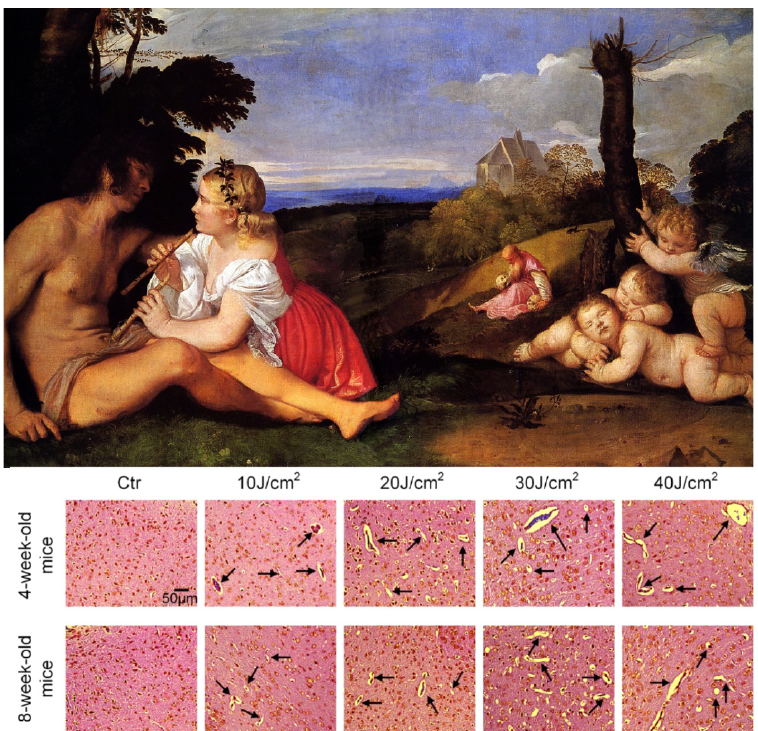
Fig. 4. The illustration of age di®erences in PDT-induced opening of the BBB. Histological analysis clearly demonstrates that PDT-induced opening of the BBB is accompanied by brain edema in laser °uence depended manner that is more pronounced in juvenile mice compared with adult mice. Ctr – the control group, no solute leakage; laser (10 – 20 – 30 – 40 J/cm 2 Þ causes the perivascular edema (black arrows), which looks as empty spaces around cerebral vessels.